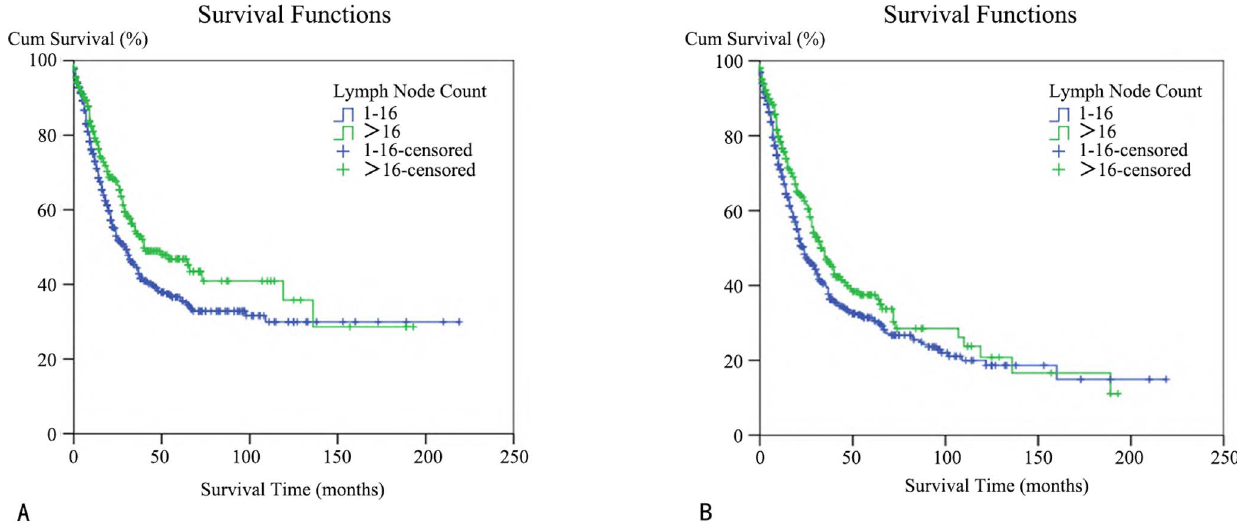
Figure 2. A Kaplan–Meier survival analysis for invasive IPMN patients after propensity score matching with different lymph node counts. (A) A cancer-specific survival (CSS) curve for patients with lymph node counts of 1–16 and over 16 is shown. (B) An overall survival (OS) curve for patients with lymph node counts of 1–16 and over 16 is shown.